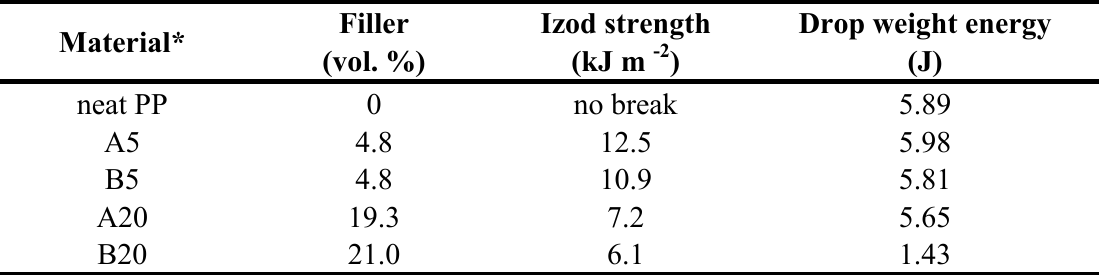
Table 1. Notched Izod strength and drop weight impact energy of PP-glass bead composites (data extracted from